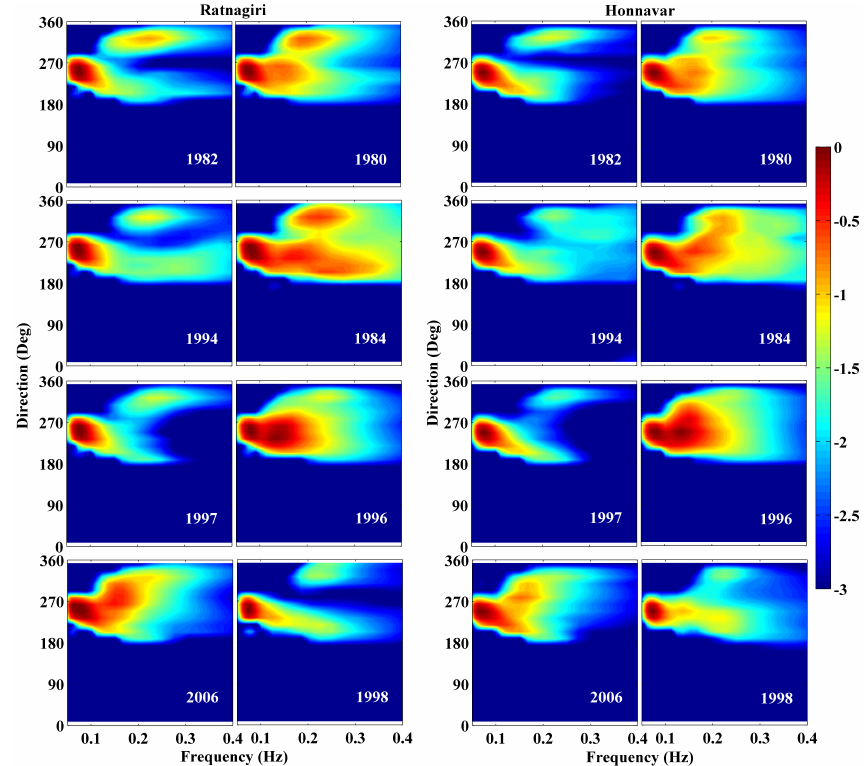
Figure 9. Modeled directional spectrum off Honnavar and Ratnagiri for selected positive and negative IOD years (first and third columns for positive IOD and second and fourth columns for negative IOD). Corresponding years are shown inside the figures and DMI are shown in Fig. 4. The spectral energy is shown in logarithmic scale base